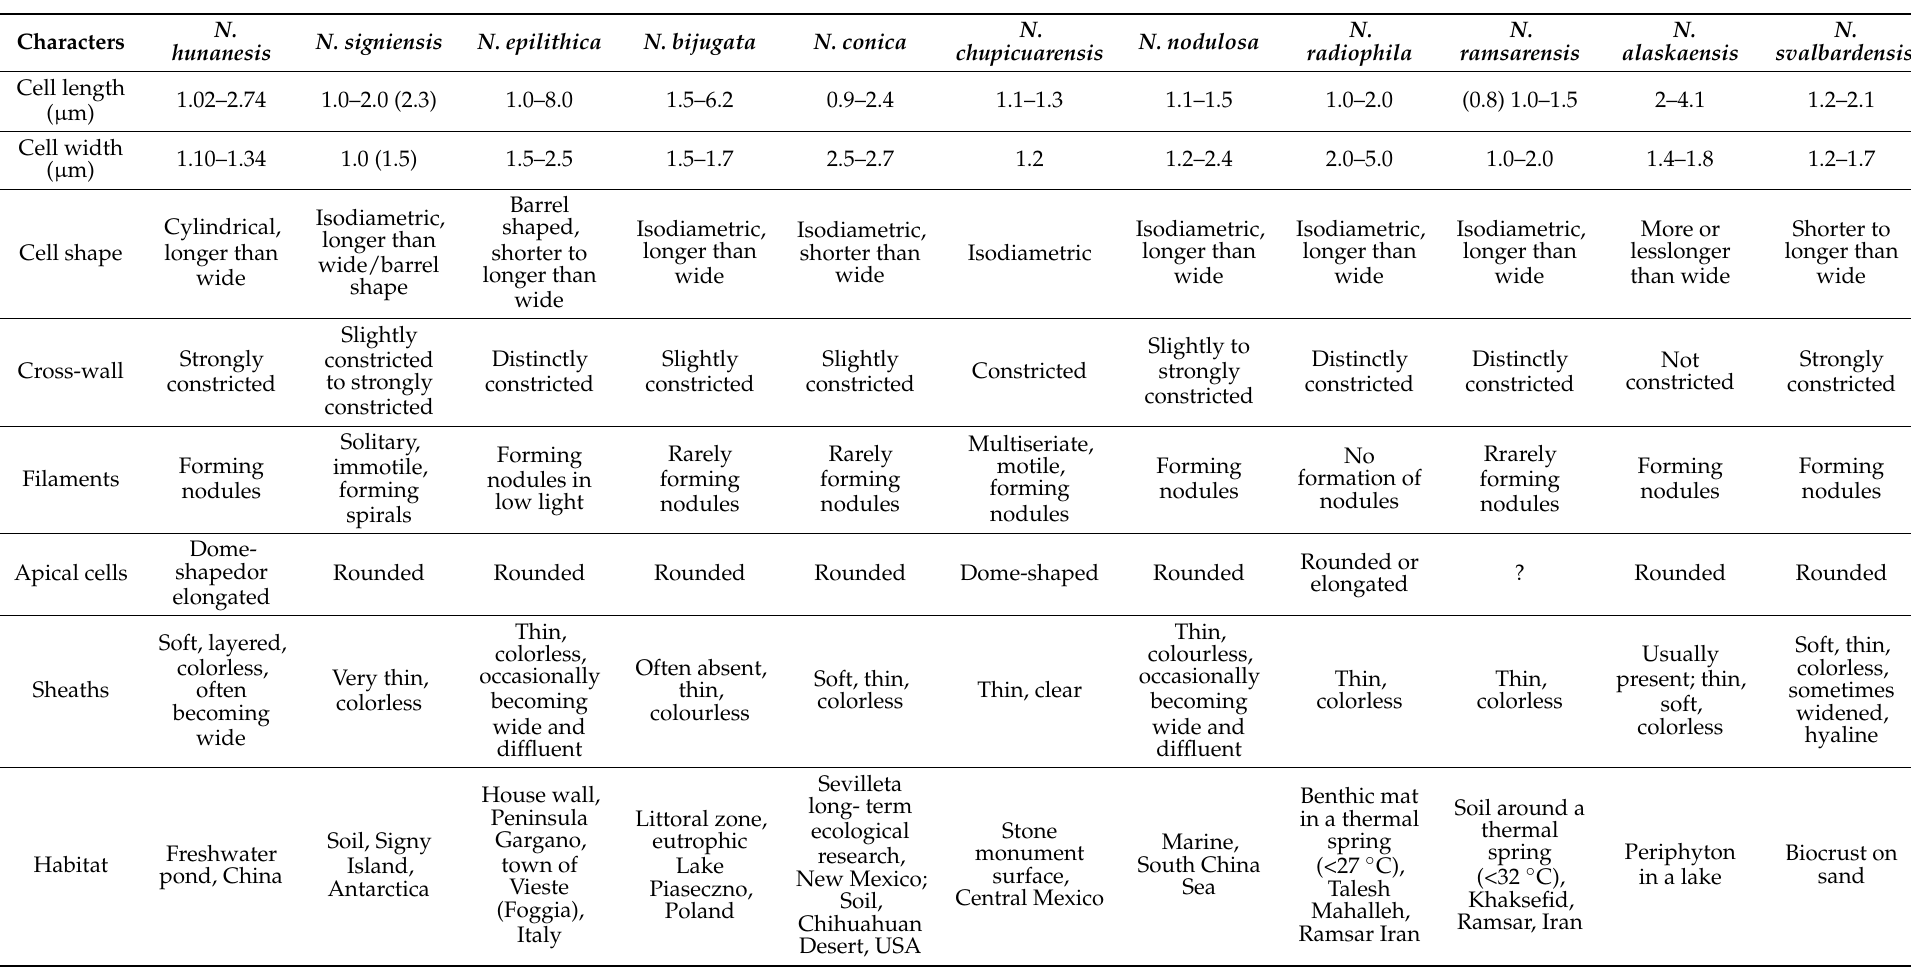
Table 2. Comparison of the characteristics of the 10 previously described species of Nodosilinea and N. hunanesis (“?” indicates that the feature is